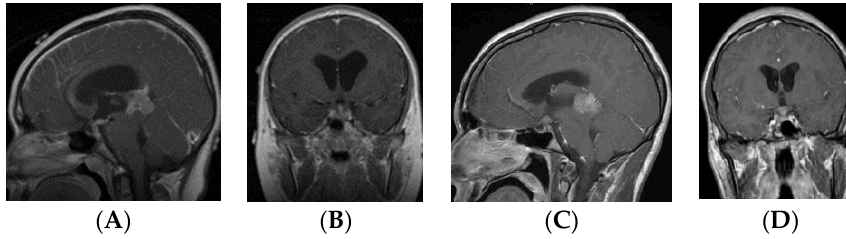
Figure 5. Type IV. Post-contrast MR, sagittal ( A ) and coronal ( B ) views of a patient with bifocal germ cell tumor (GCT). Note a laminar tumor at the floor of the third ventricle with upper pituitary stalk involvement. Post-contrast MR, sagittal ( C ) and coronal ( D ) views of a patient with bifocal GCT with a nodular tumor at the floor of the third ventricle with upper pituitary stalk involvement.